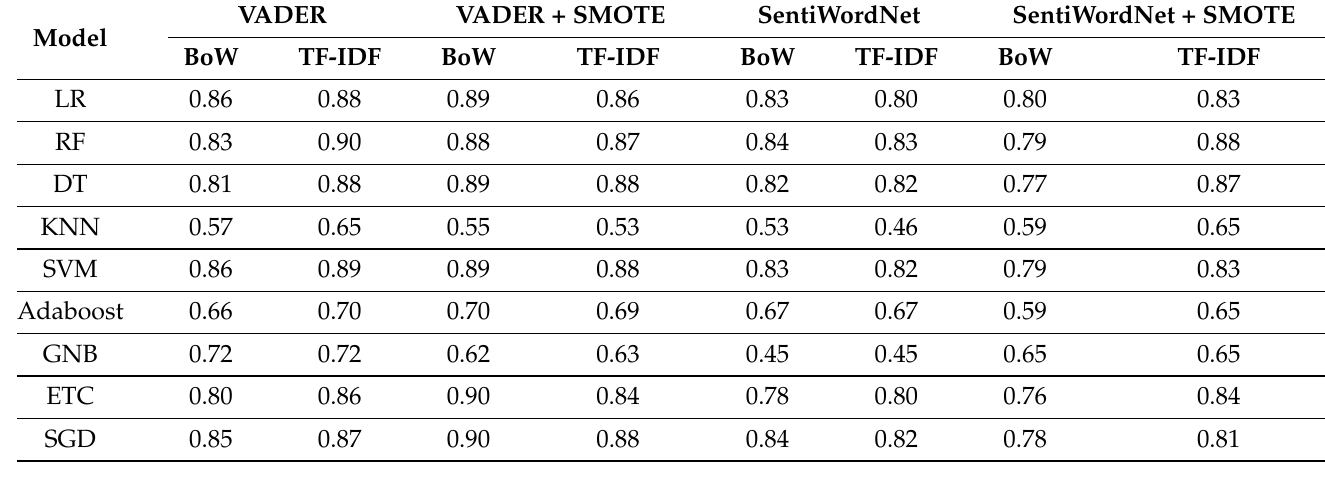
Table 18. Model results using the VADER and SentiWordNet technique.